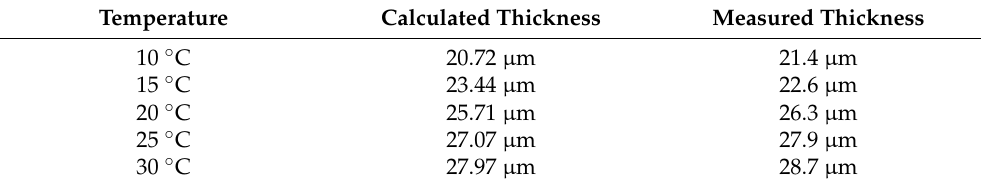
Table 4. Calculated and measured film thickness with different